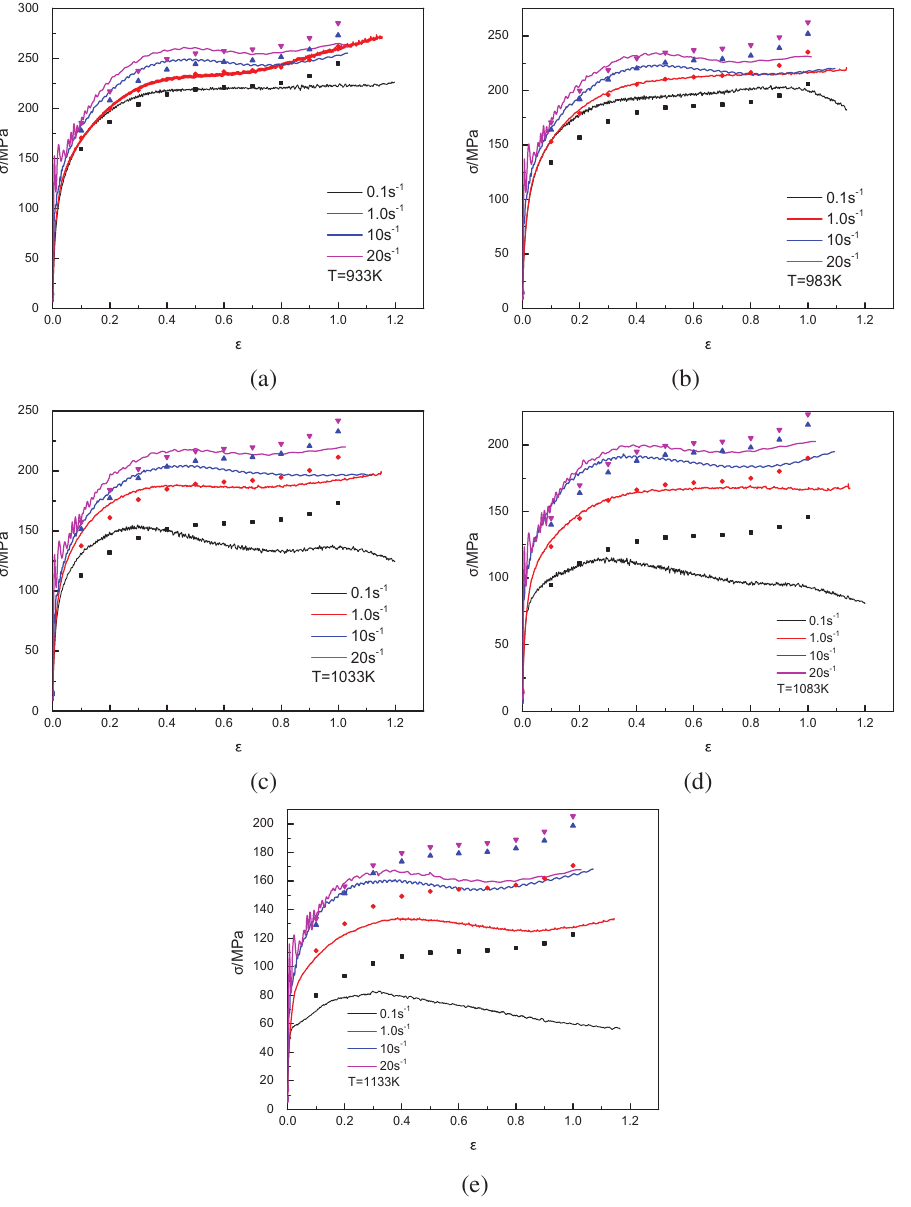
Figure 10: Comparison between experimental and predicted flow stress using Johnson – Cook model at the temperatures of (a) 933 K, (b) 983 K, (c) 1,033 K, (d) 1,083 K, (e) 1,133